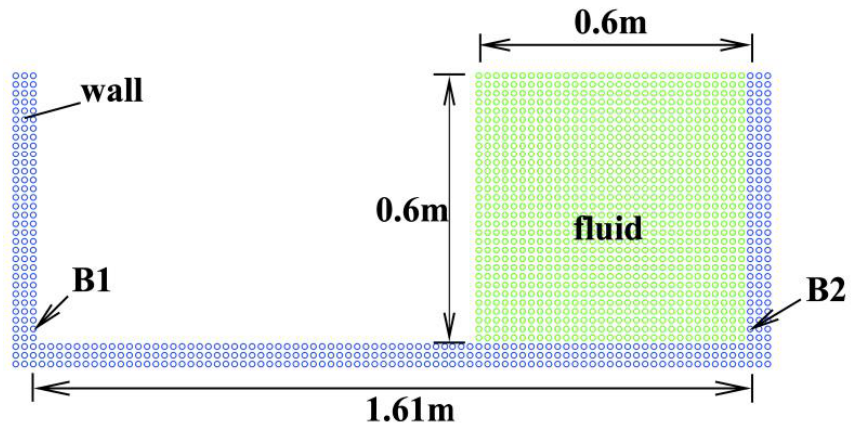
Figure 12. Schematic diagram of pool size.